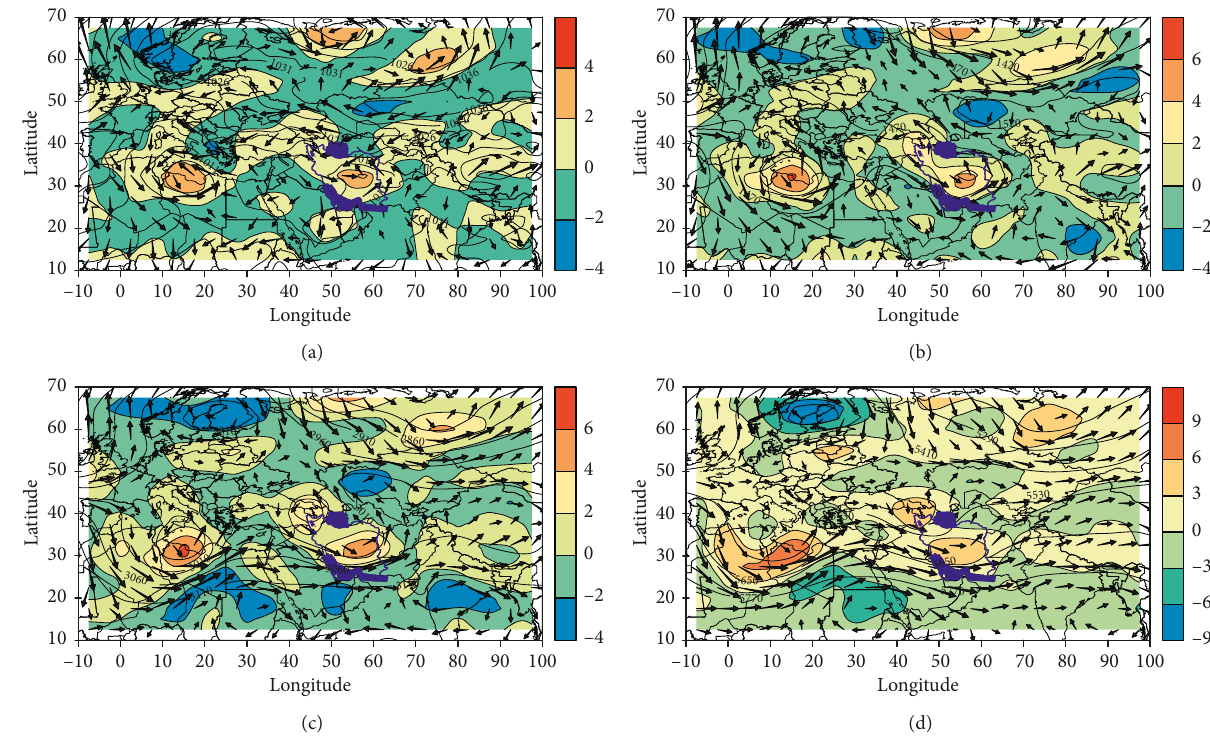
Figure 7: (a) 1000hPa height (contours), vorticity (5 × 10 − 5 ), and wind flow (m/s). (c) 700 hPa height, vorticity (5 × 10 − 5 (5 × 10 − 5 S − 1 wind flow